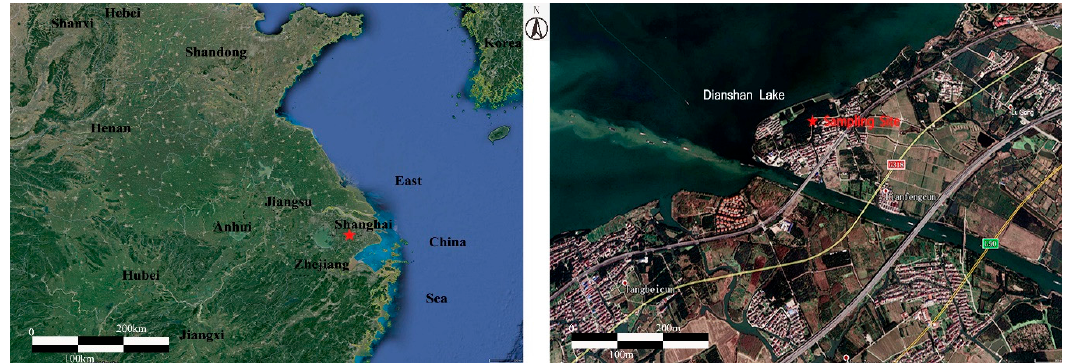
Figure 1. Location of sampling site in Shanghai.